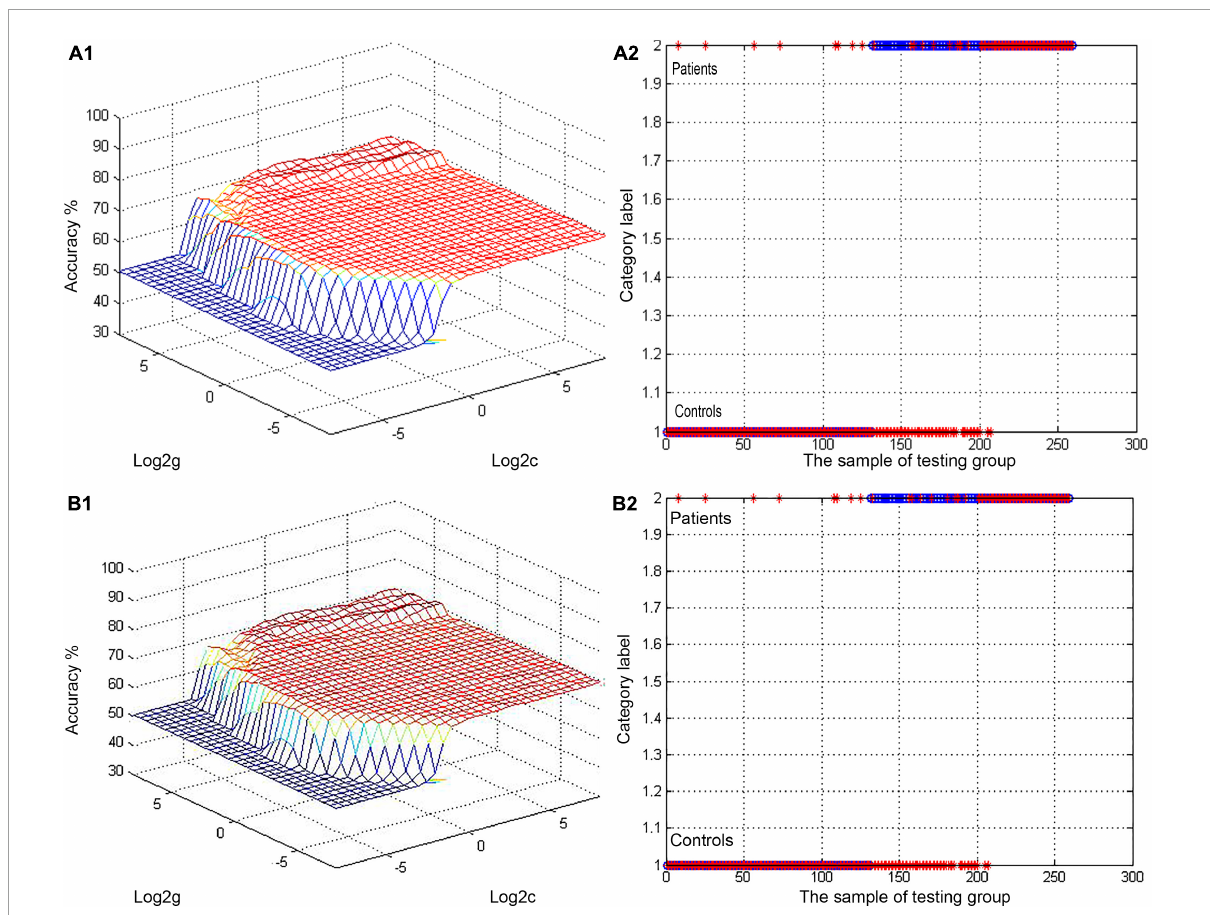
FIGURE2 (A,B) Visualization of SVM classification based upon reduced ALFF values in the bilateral PCu and left AG as a means of differentiating between SCH patients and HCs. A1/2: 3D visualization of SVM with the most optimal parameters; B1/2: classification map of ALFF values for the bilateral PCu/left AG. SVM, support vector machine; ALFF, amplitude of low-frequency fluctuation; AG, angular gyrus; PCu, precuneus; SCH, schizophrenia; HCs, healthy